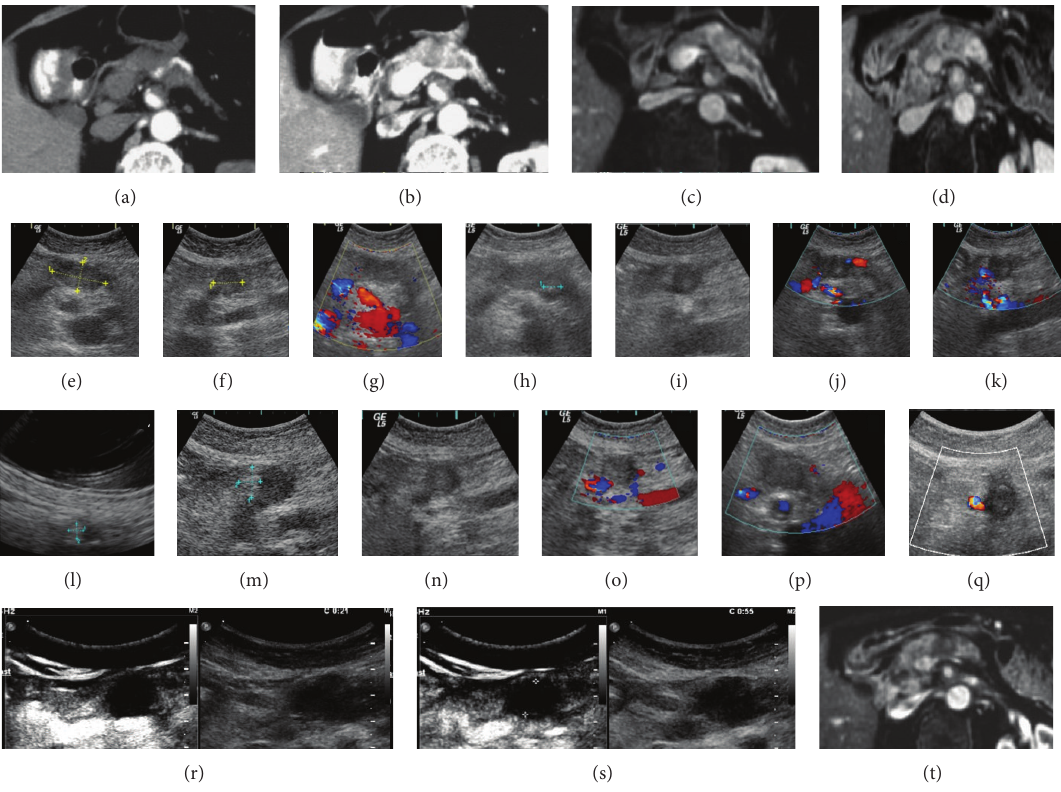
Figure 4: A 78-year-old woman with about 4.6 × 1.5 × 1.6 cm pancreatic body carcinoma. The pre- HIFU enhanced CT ((a) and (b)) and MRI ((c) and (d)) showed inhomogeneous enhancement within the lesions. Ultrasound showed hypoechoic lesions ((e) cross section and (f) longitudinal section) with clear boundary, internal homogeneous echo, and no obvious blood flow signal (g). In the 8th treatment, ultrasound showed increase of ultrasound reflection intensity within 1.0 × 1.0 cm ((h) cross section and (i) longitudinal section) on left lesions, but no obvious blood flow signal ((j) cross section and (k) longitudinal section). In the 12th treatment, ultrasound observed significant increase of ultrasound reflection intensity within 1.2 × 0.8 cm in the upper area of the lesions ((l) and (m)). In the 19th treatment, ultrasound showed mild enhancement in tumor central area with unclear boundary (n); CDFI showed no obvious internal blood flow signal (o). In the 20th treatment, ultrasound showed internal heterogeneous enhancement with unclear boundary and no blood flow signal ((p) cross section and (q) longitudinal section). After the whole HIFU treatments, ultrasound showed no contrast agent filling within the lesions ((r) 21 󸀠󸀠 and (s) 55 󸀠󸀠 ). A month later, enhanced MRI showed no obvious enhancement with the tumor central area